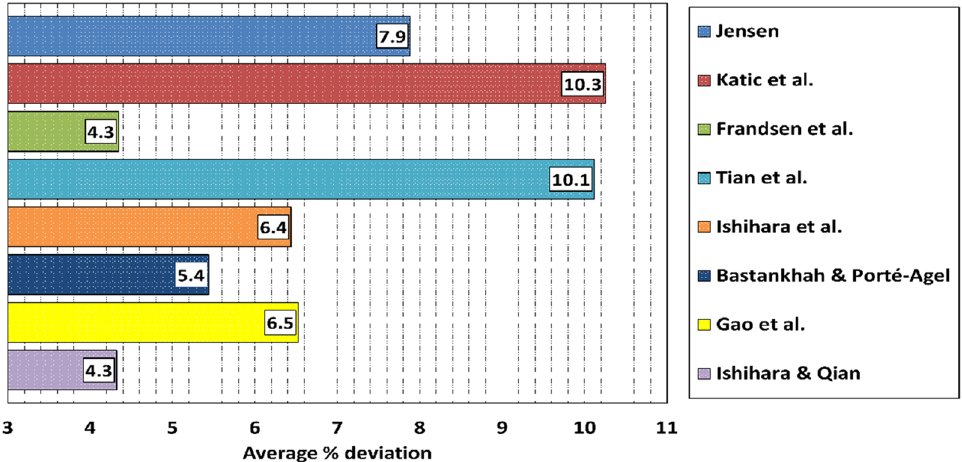
Fig. 14. Cumulative average percentage deviations for all